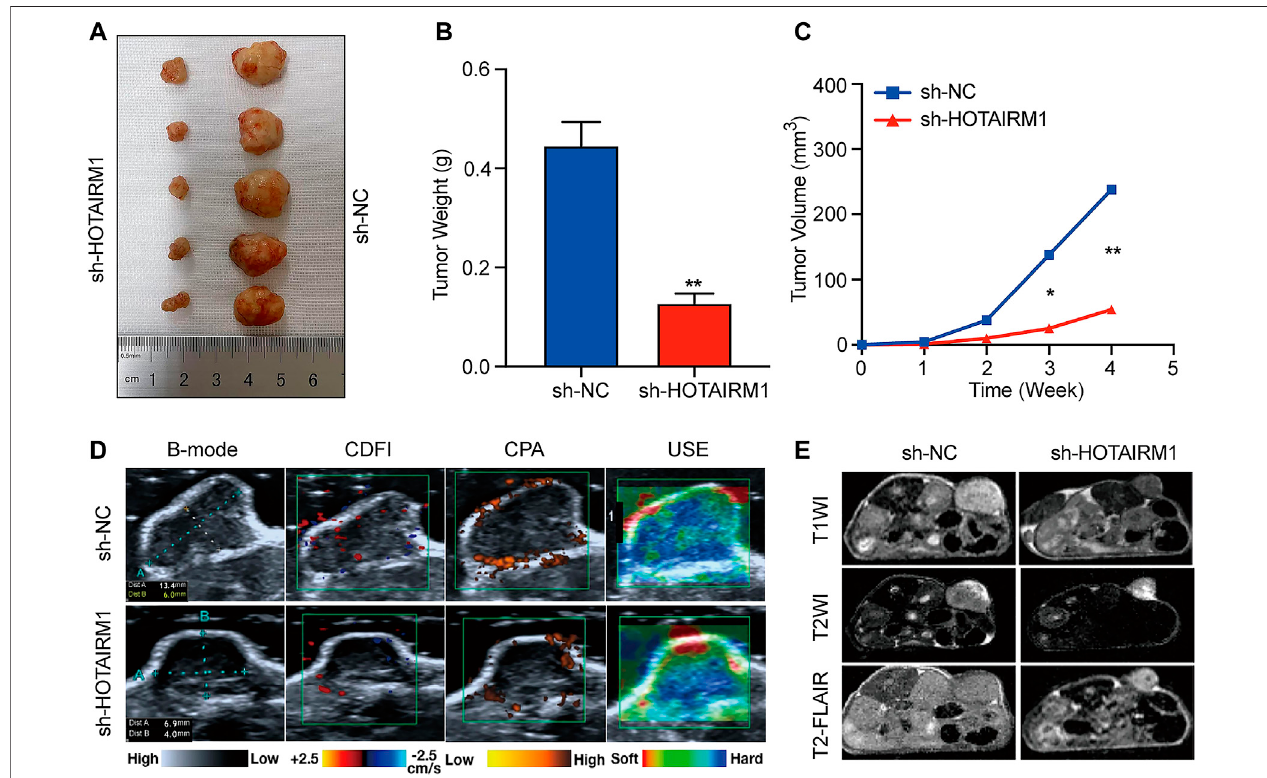
FIGURE7| Knockdown ofHOTAIRM1inhibits tumor growth invivo . (A) Tumorswereexcised from nudemice atday 28after tumor graftinoculation ( n (cid:1) 5). (B – C) Weight of tumors and Volume were measured and calculated. (D) USI evaluation of tumors in mice using B-mode, CDFI, CPA, and USE. (E) MRI evaluation of tumors using T1WI, T2WI and T2- FLAIR. * p < 0.05, ** p <